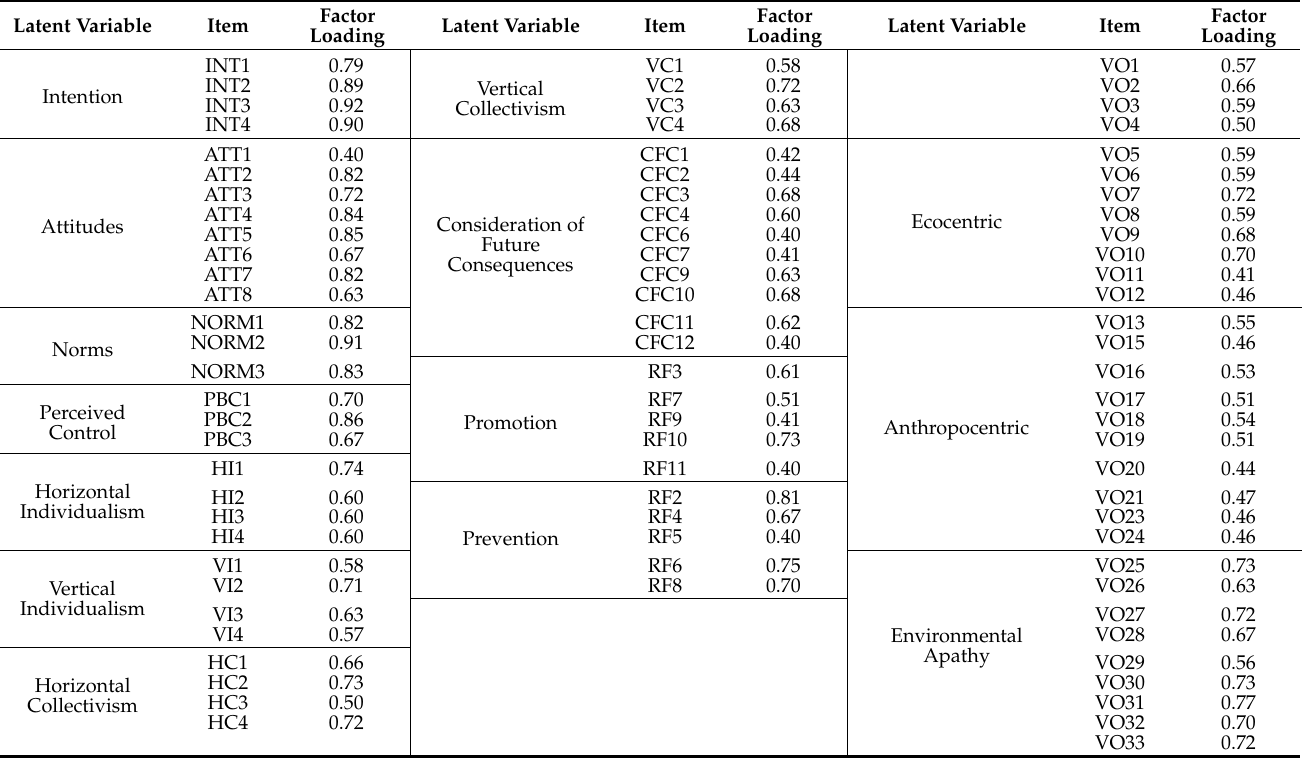
Table 1. EFA measurement results.